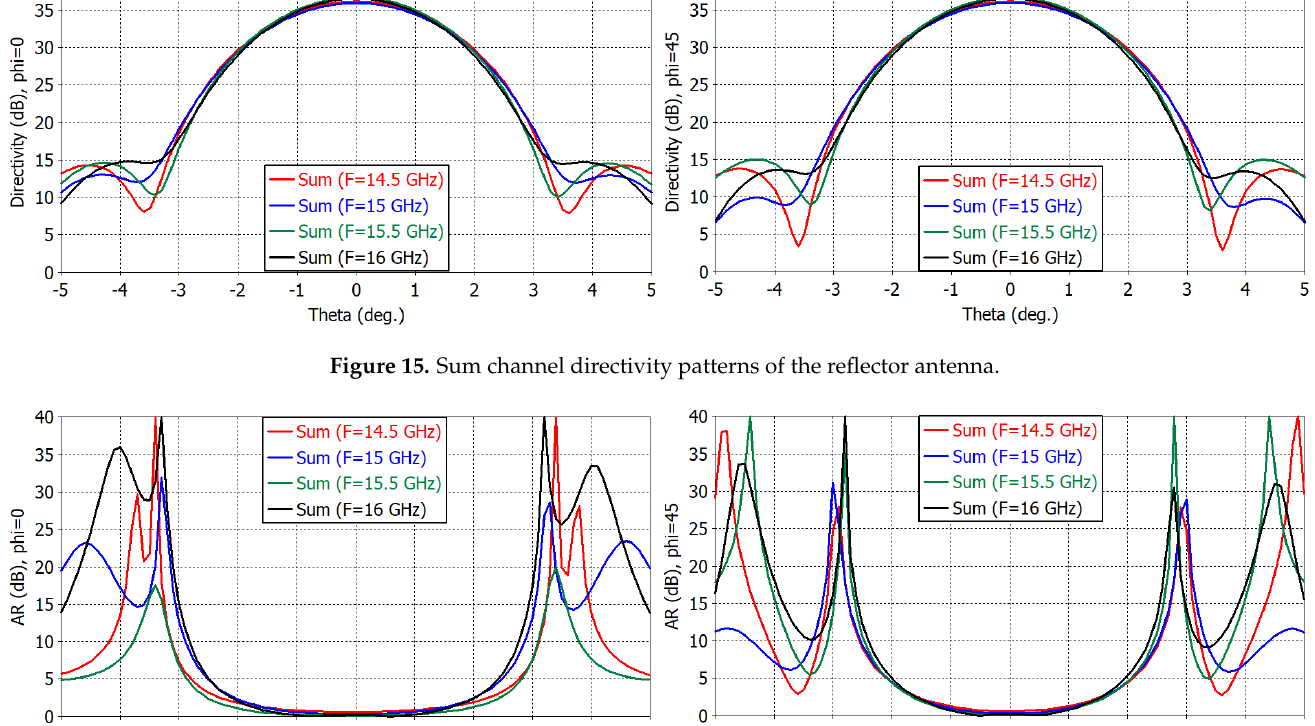
Figure 15. Sum channel directivity patterns of the reflector antenna. Figure 16. Sum channel axial ratio patterns of the reflector antenna.